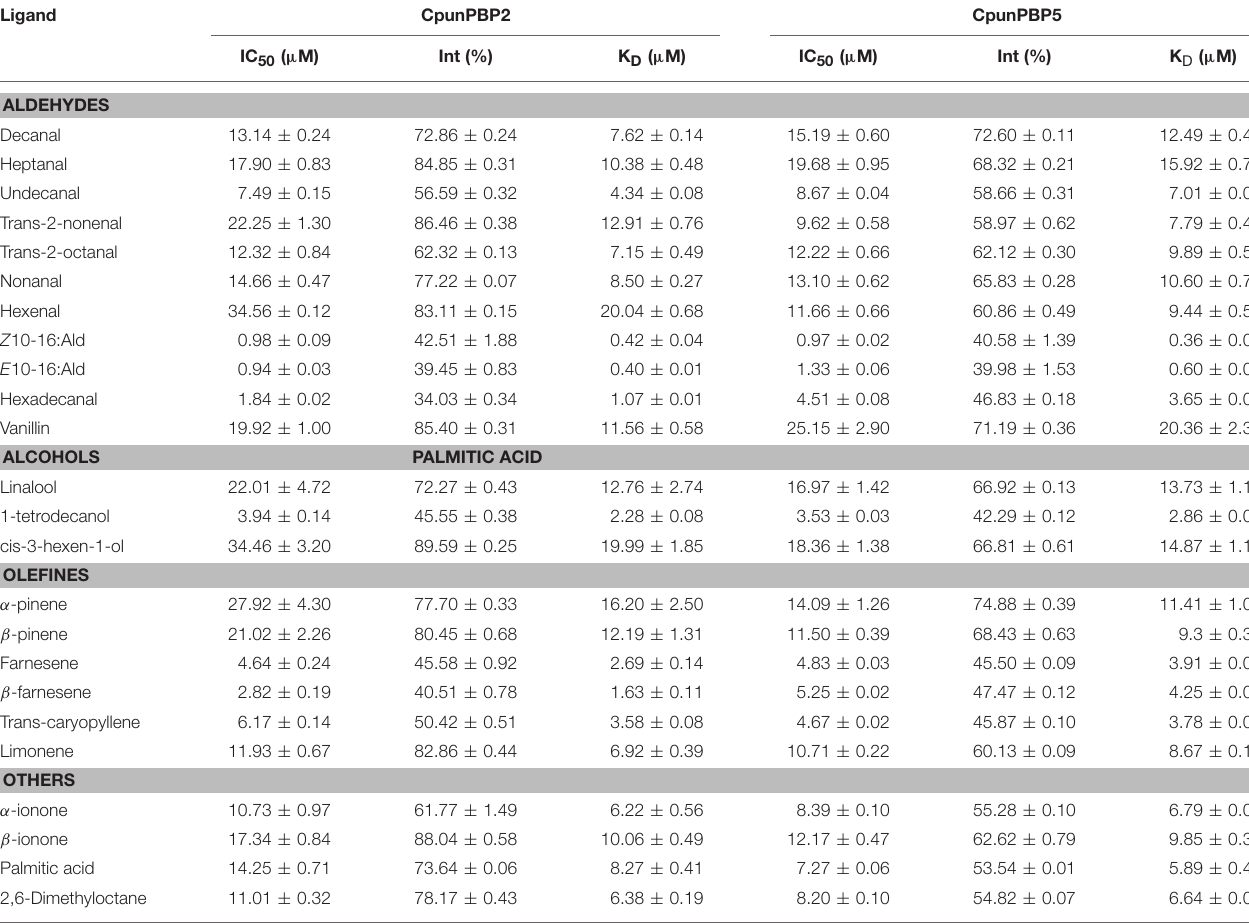
TABLE 1 | IC 50 values ( µ M) and calculated dissociation constants (K D ) ( µ M) of CpunPBP2 and CpunPBP5 to different ligands at pH =